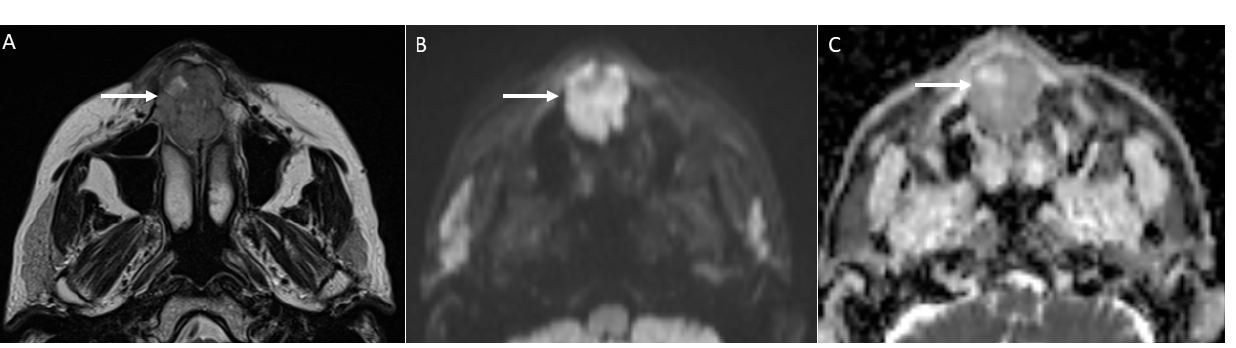
Figure 5. Squamous cell carcinoma of the hard palate. ( A ) Axial T2 image; ( B ) DWI trace (b = 1000); ( C ) ADC map. The mass of the hard palate (white arrows) shows restricted diffusion represented by high signal intensity on the DWI trace ( B ) and low values on the ADC map ( C ) (1.16 × 10 − 3 mm 2 /s).